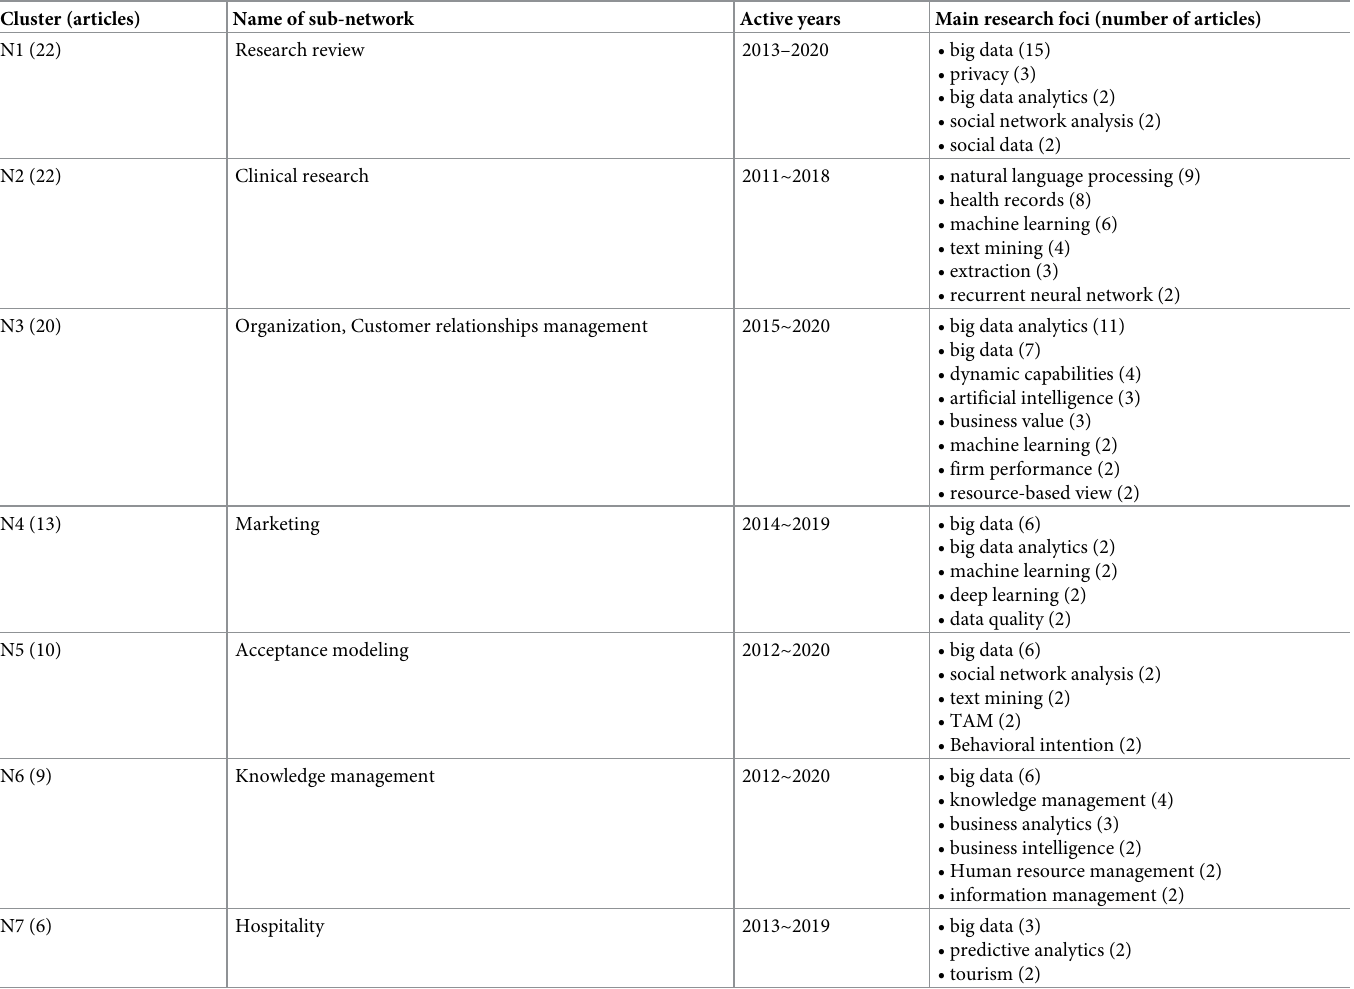
Table 4. Summary of research foci in Global North